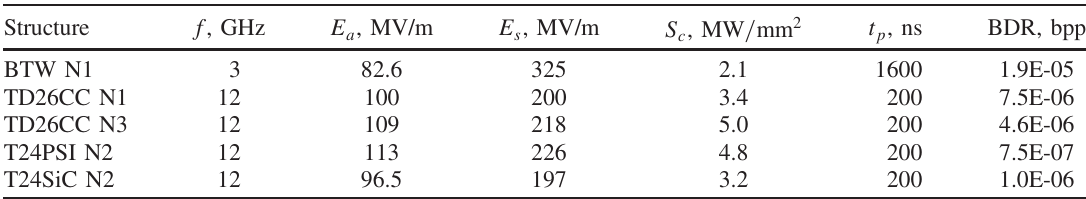
Table II. A detailed description of the total analysis of the BTW structure is presented in